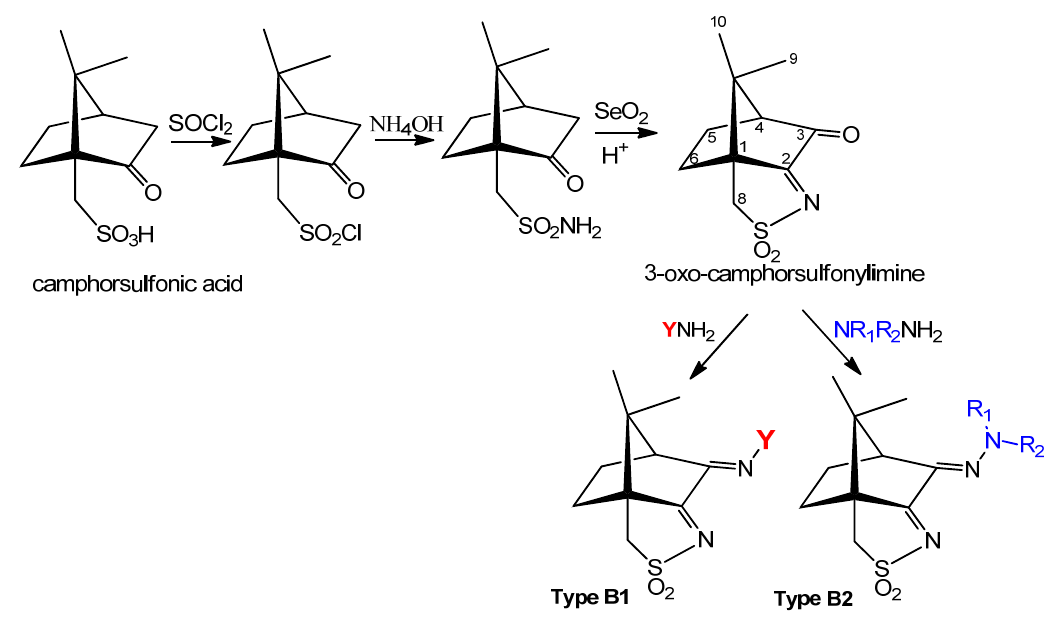
Figure 5. Camphorsulfonic acid derivatives of the camphorsulfonimine type.